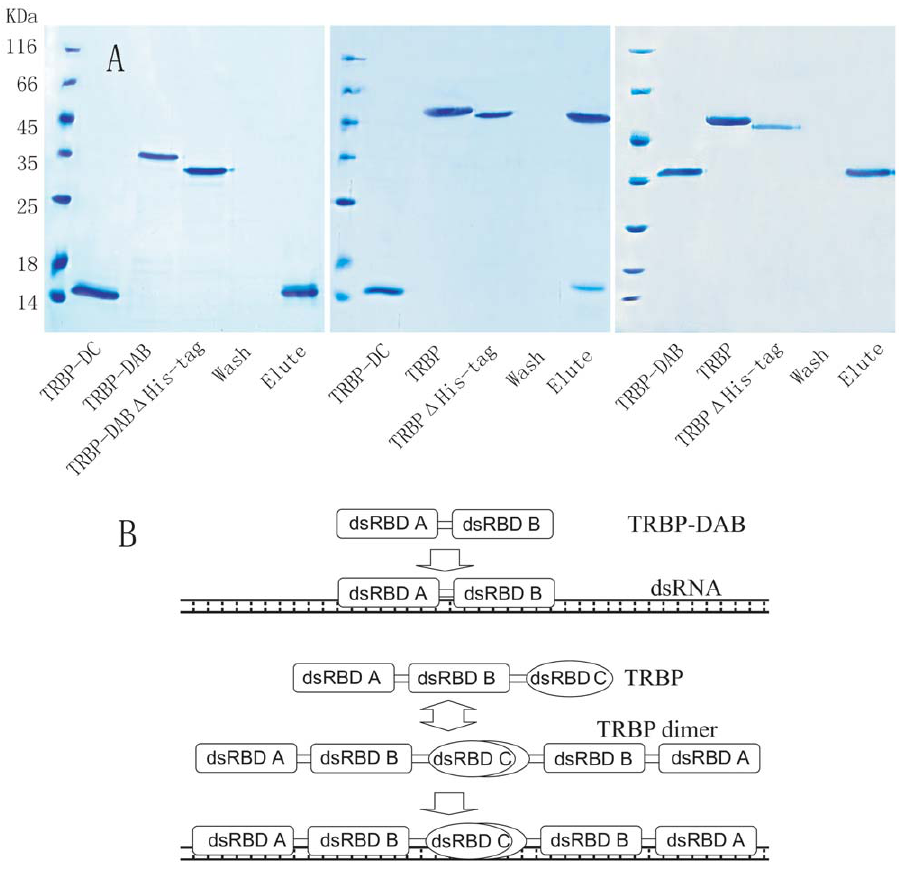
Figure 5. A: Pull-down assays showing that TRBP-DC mediates the homo-dimerization of TRBP in shrimp. Left: Recombinant His-tagged TRBP-DC was incubated with His-Bind resin, and then TRBP-DAB D His-tag was added. After stringent wash, only TRBP-DC was eluted, indicating TRBP-DAB could not bind to TRBP-DC. Middle: Pull down assay was performed to identify the interaction between TRBP-DC and full length TRBP, and both proteins could be eluted, suggesting the interaction between TRBP-DC and full length TRBP. Right: pull down assay show TRBP-DAB could not bind to full length TRBP. These results indicate that TRBP-DC mediates the dimerization of full length TRBP. B: Illustration of the differences in affinity of full length TRBP and TRBP-DAB to dsRNA in shrimp. TRBP-DAB binds dsRNA uncooperatively and exhibits lower affinity. C-terminal dsRBD of TRBP mediate the dimerization of TRBP, resulting in a higher affinity of TRBP to dsRNA compared to TRBP-DAB.